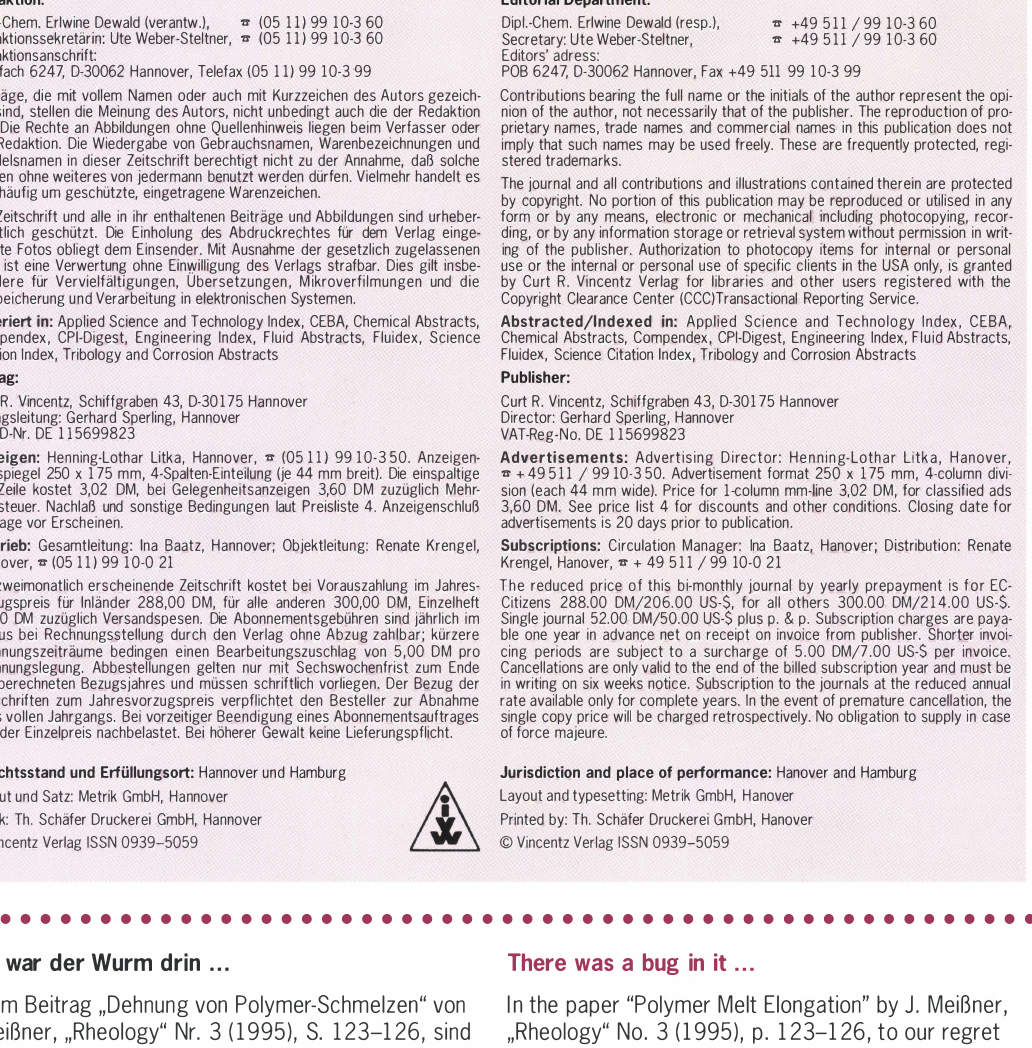
Fig. 6: Elongational viscosity of the polystyrene melt of Fig. 5 and comparison with the threefold of the shear viscosity